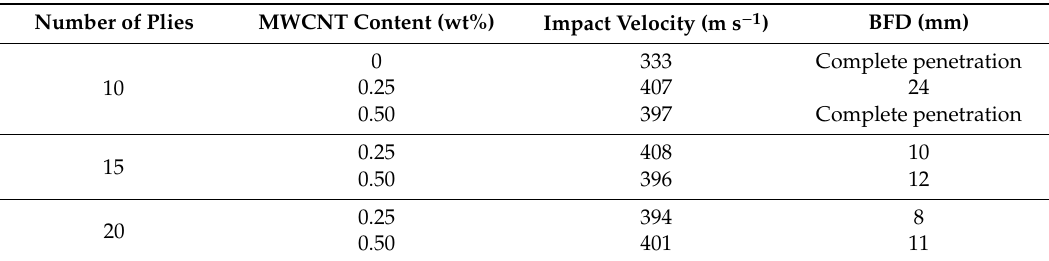
Table 4. Experimental tests for back face deformation (BFD) of the nanocomposite laminates containing 0.25 wt%, and 0.50 wt%